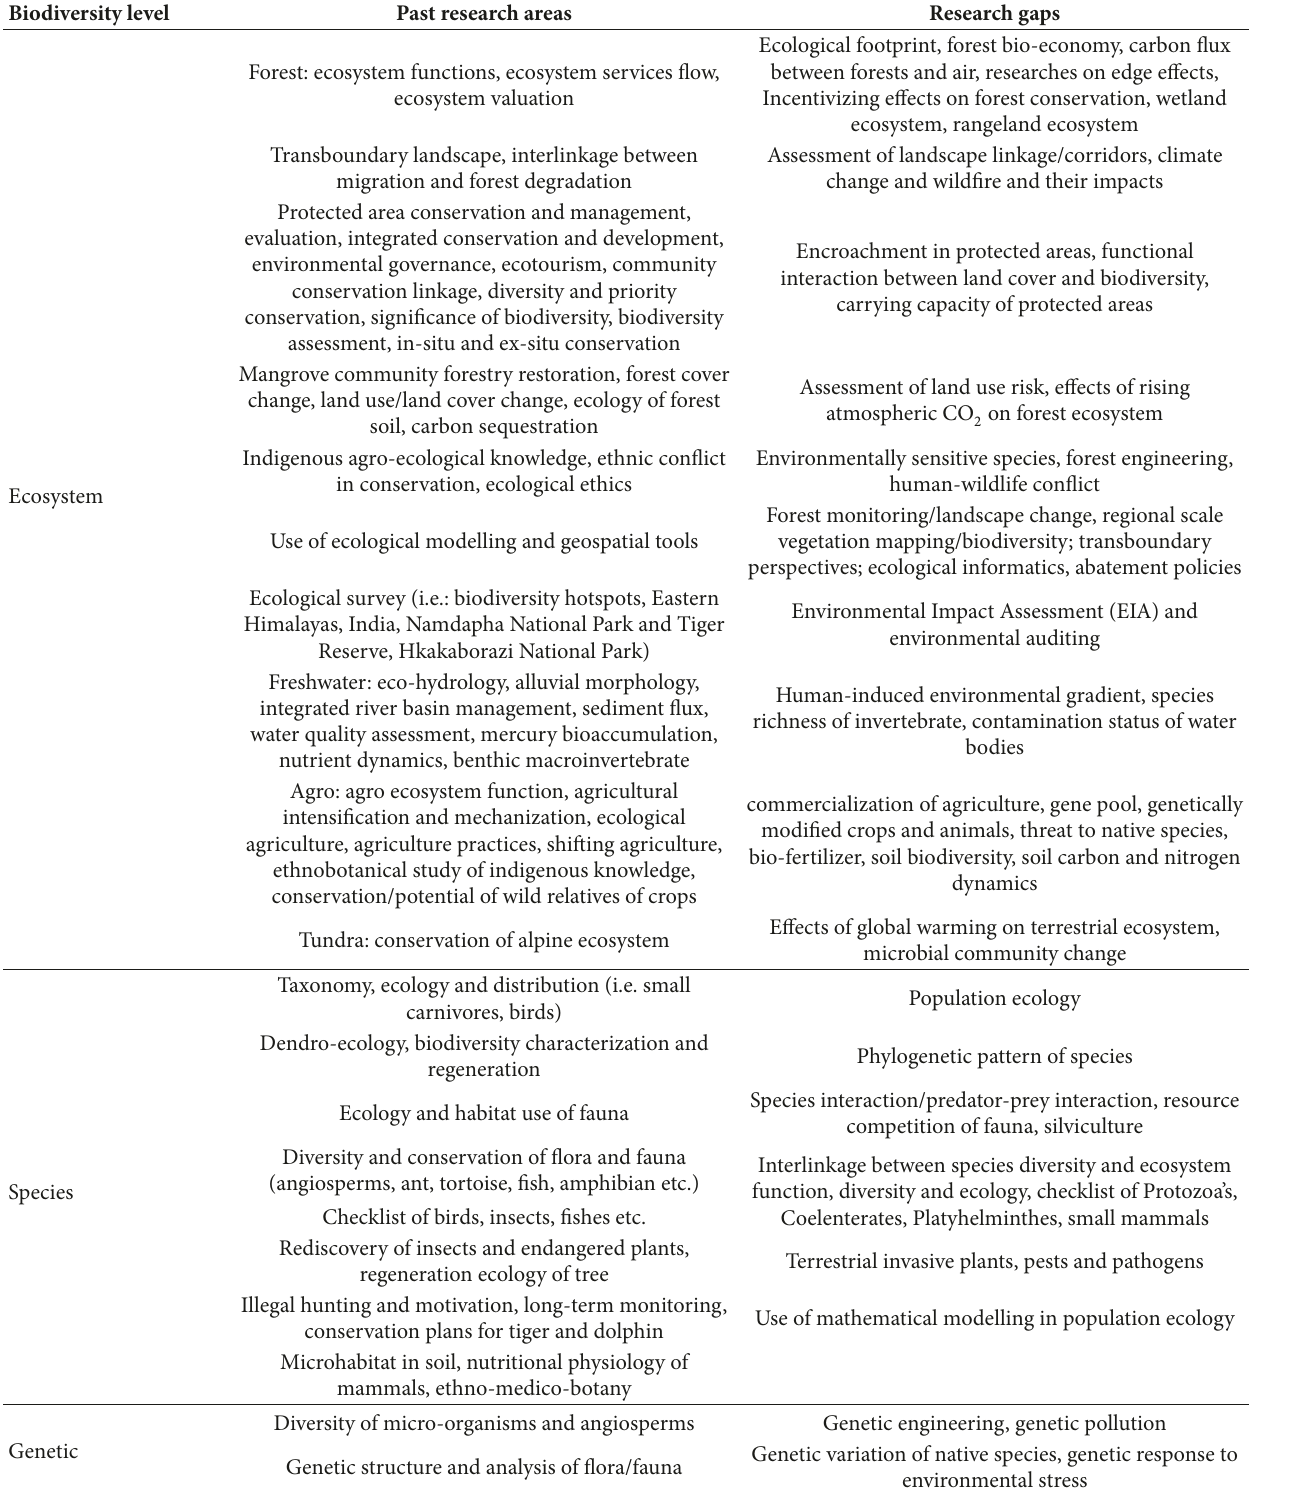
Table 2: Past research areas, gaps/investments for